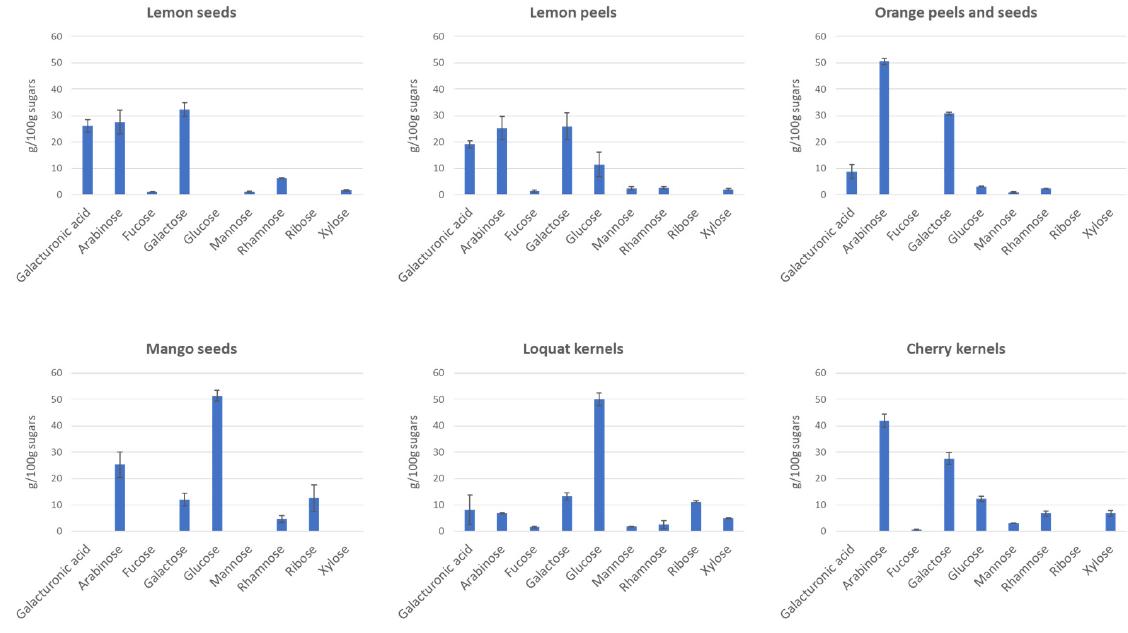
Figure 2. Sugar composition (expressed as g sugar/100 g total sugars) of six fruit by-products. Soluble fibre of loquat kernels and mango seeds were the only ones containing glu- cose as the main monosaccharides, suggesting a potential significant presence of starch, as highlighted in Section 3.1, which needs to be further evaluated in terms of the purifica- tion process. Ethanol, in fact, may cause the co-precipitation of starch with fibres [23]. In such case, the use of amylolytic enzymes, resembling conditions used for gravimetric quantification of soluble fibres [14] could be therefore appropriate, but it was excluded in this protocol to avoid the presence of simple sugars in the hydrolyzed protein